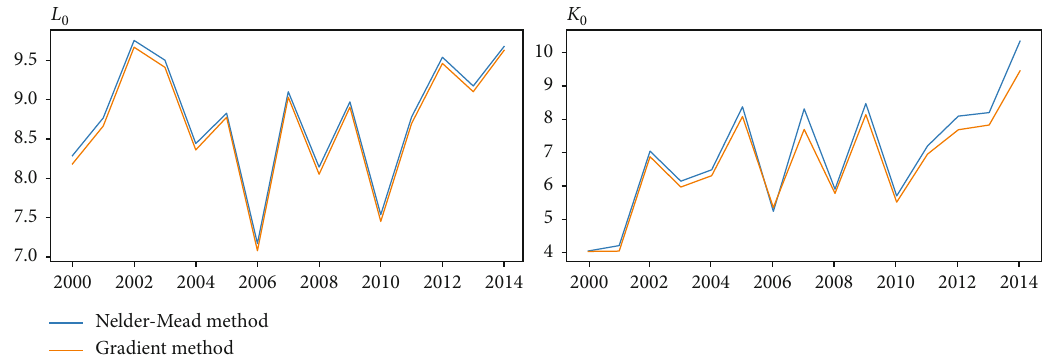
0 and biochemical oxidation rate